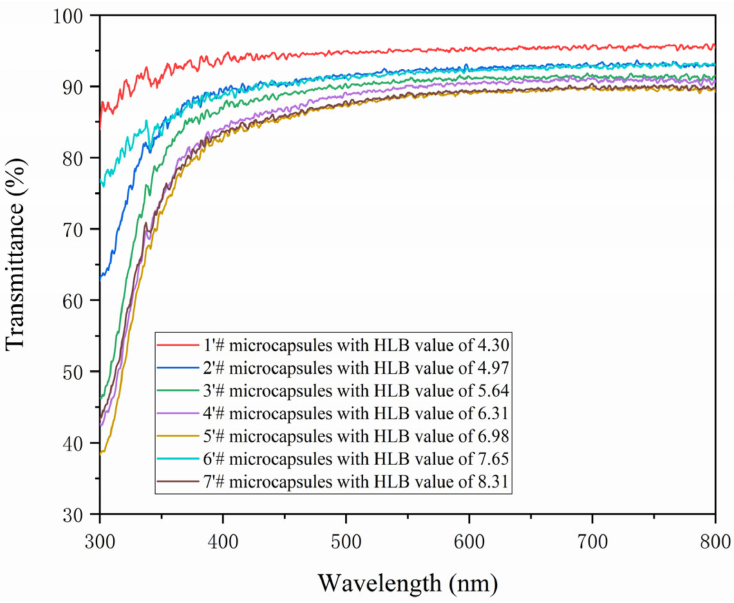
Figure 7. The transmittance diagram of the coating prepared by HLB values of different emulsifiers. Table 8. Visible light transmittance of microcapsule antibacterial coatings with different HLB